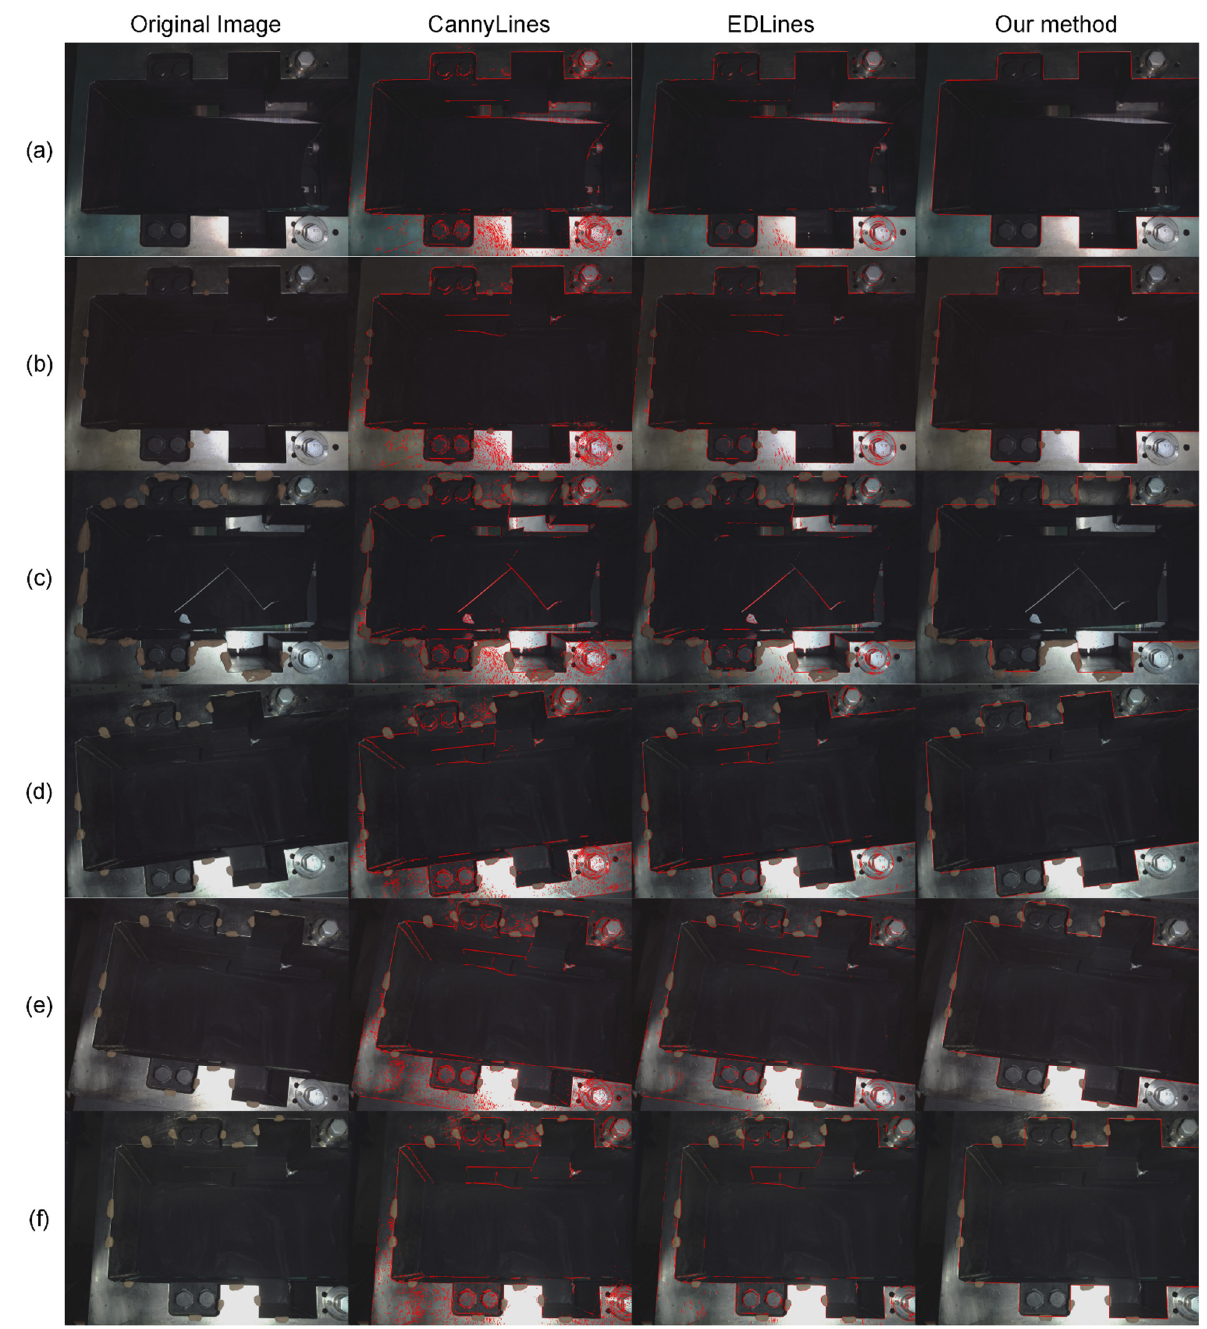
Figure 16. Results of line detection experiment under different conditions: ( a ) No pollution; ( b ) Light pollution; ( c ) Heavy pollution; ( d – f ) Different poses. pollution; ( c ) Heavy pollution; ( d – f ) Different